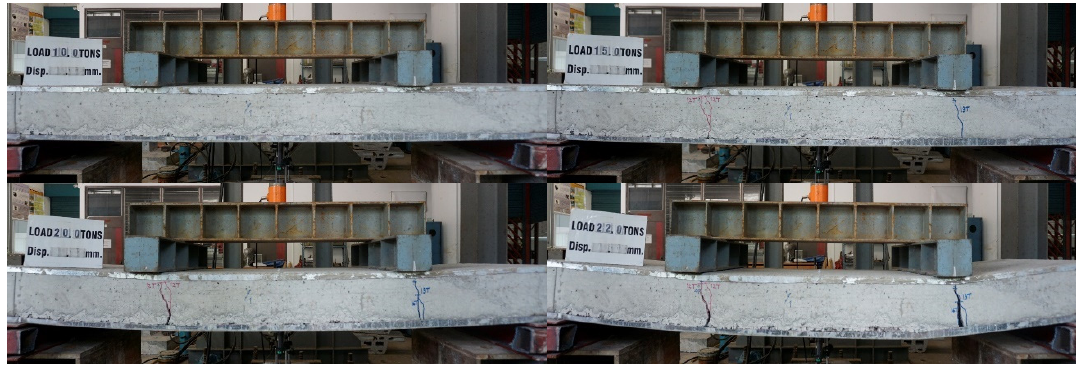
Figure 8. Crack patterns of specimen S3.